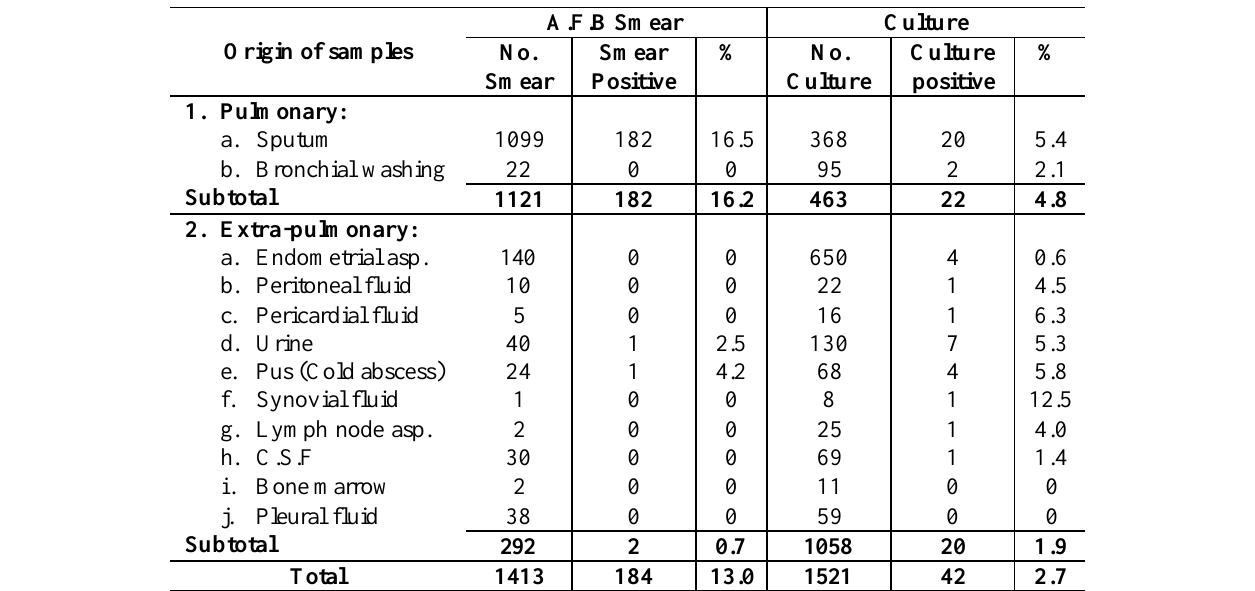
Table I : Bacteriological investigations and isolates in TUTH